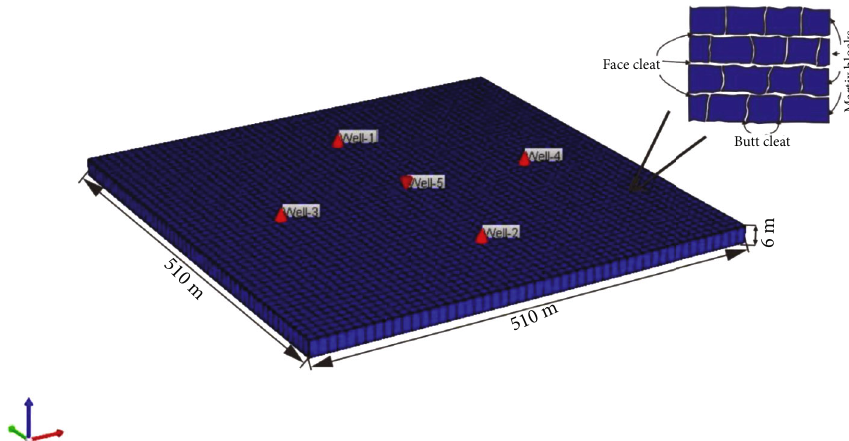
Figure 1: Geological model of coal reservoir in this study.